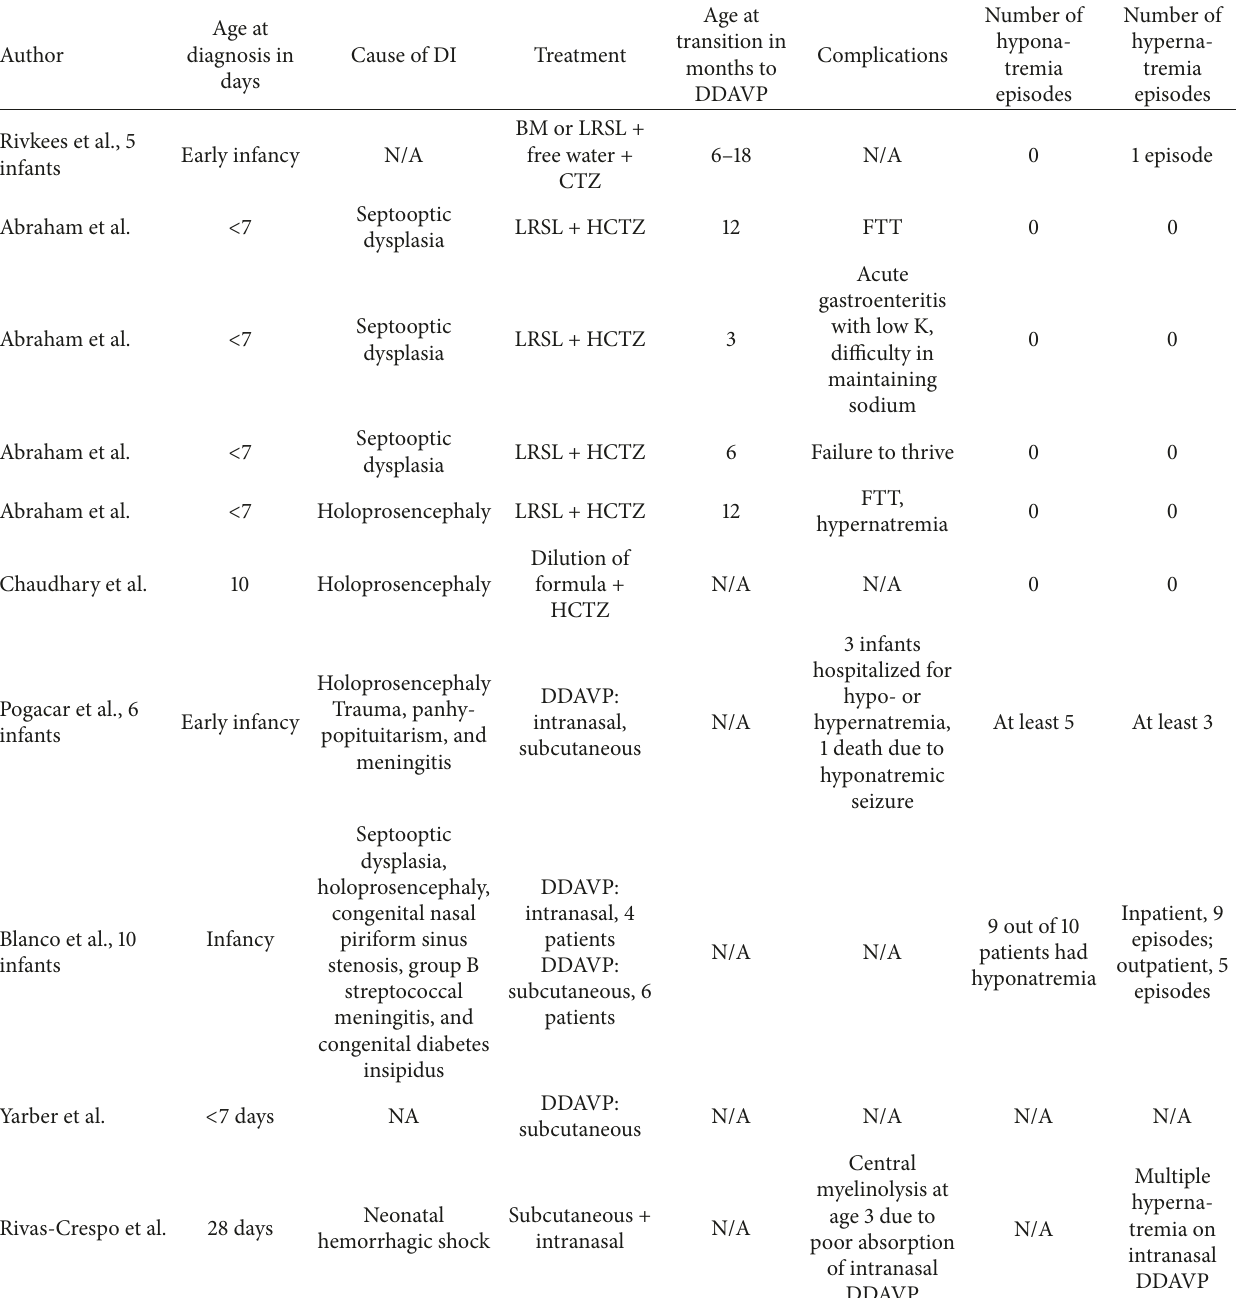
Table 1: Summary of cases of central diabetes insipidus in